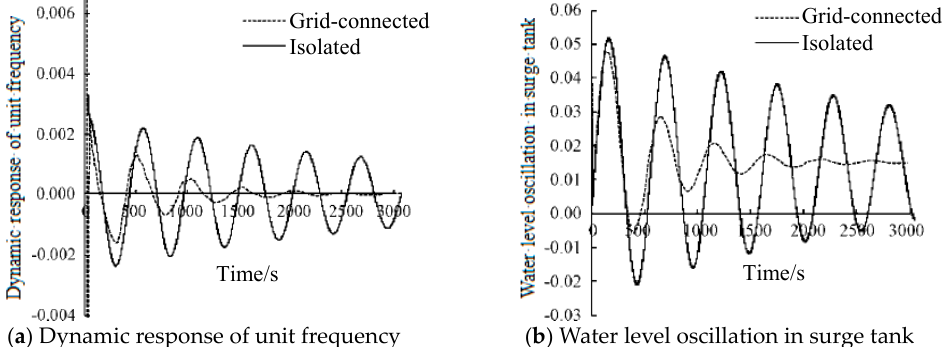
Figure 17. Dynamic response of unit frequency and water level oscillation in the surge tank under the grid-connected operation condition and isolated operation condition [74].